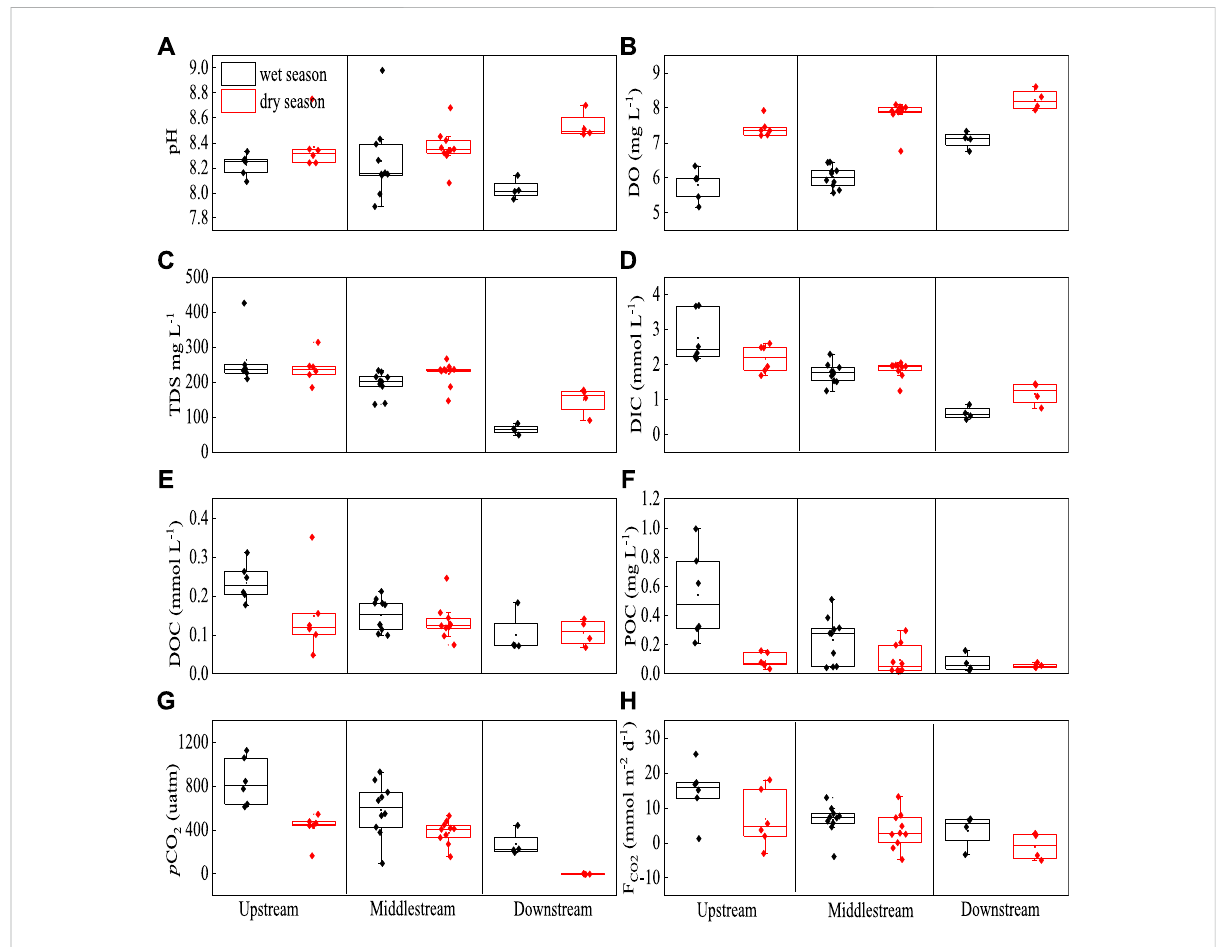
FIGURE 4 BoxdiagramofpH,DO,TDS,DIC,DOC,POC, p CO 2 ,andF CO2 indifferentreachesofYTRiver(themiddleline,loweredgeandupperedge,dots in or outside the boxes refer to mean values, 25th and 75th, 5th and 95th, and < 5th and > 95th percentiles of all data,